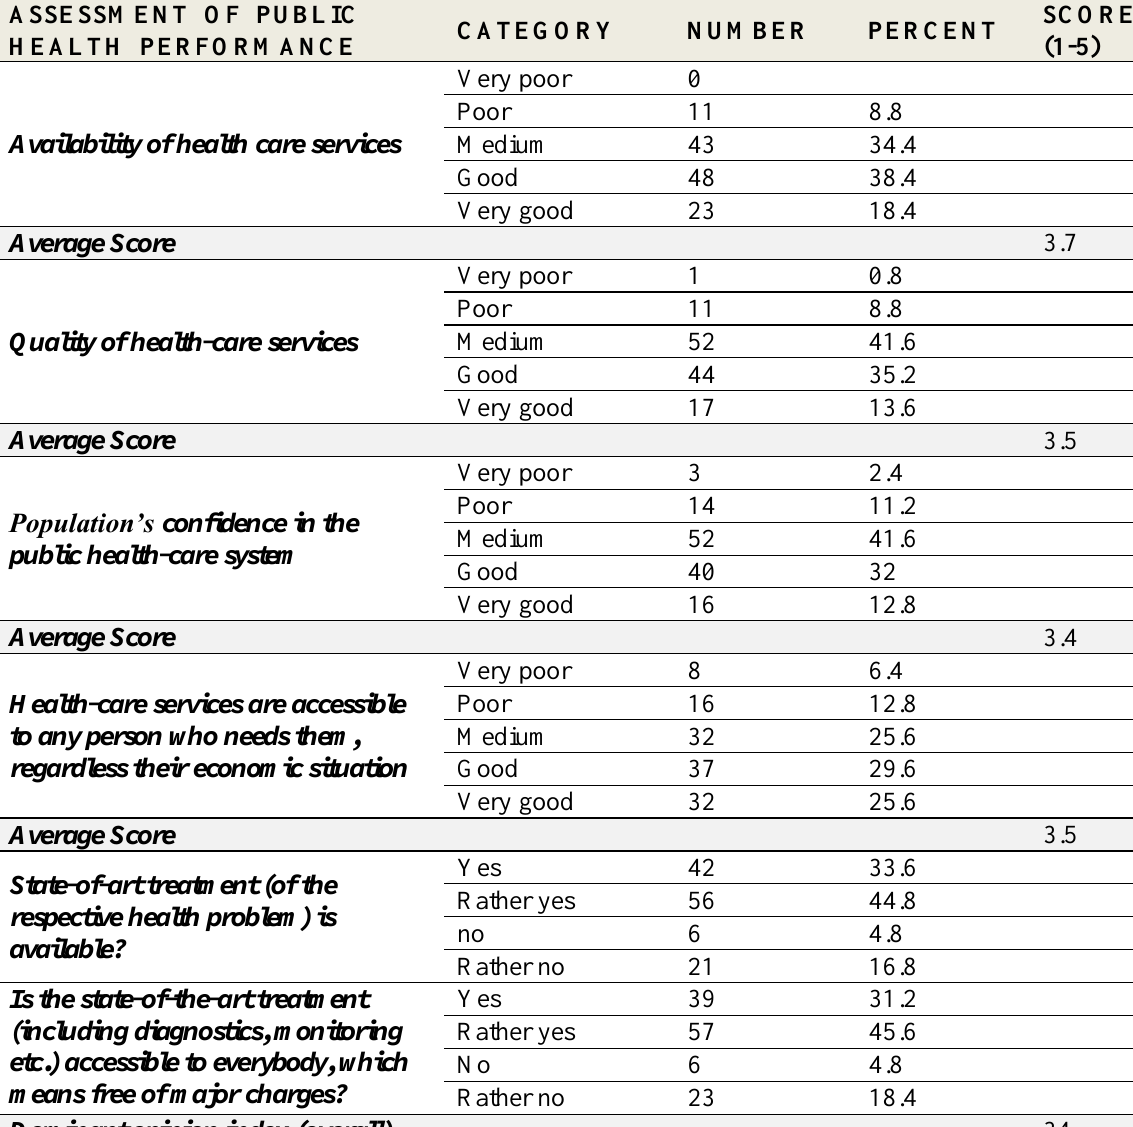
Table 3. Assessment of the performance of public health care system in the Republic of Macedonia ASSESSMENT OF